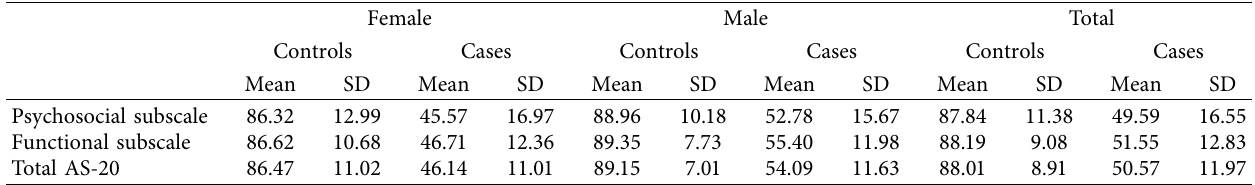
Table 3: The multivariate analysis of the association of the participants’ sociodemographic and clinical characteristics with the total AS-20, psychosocial, and functional